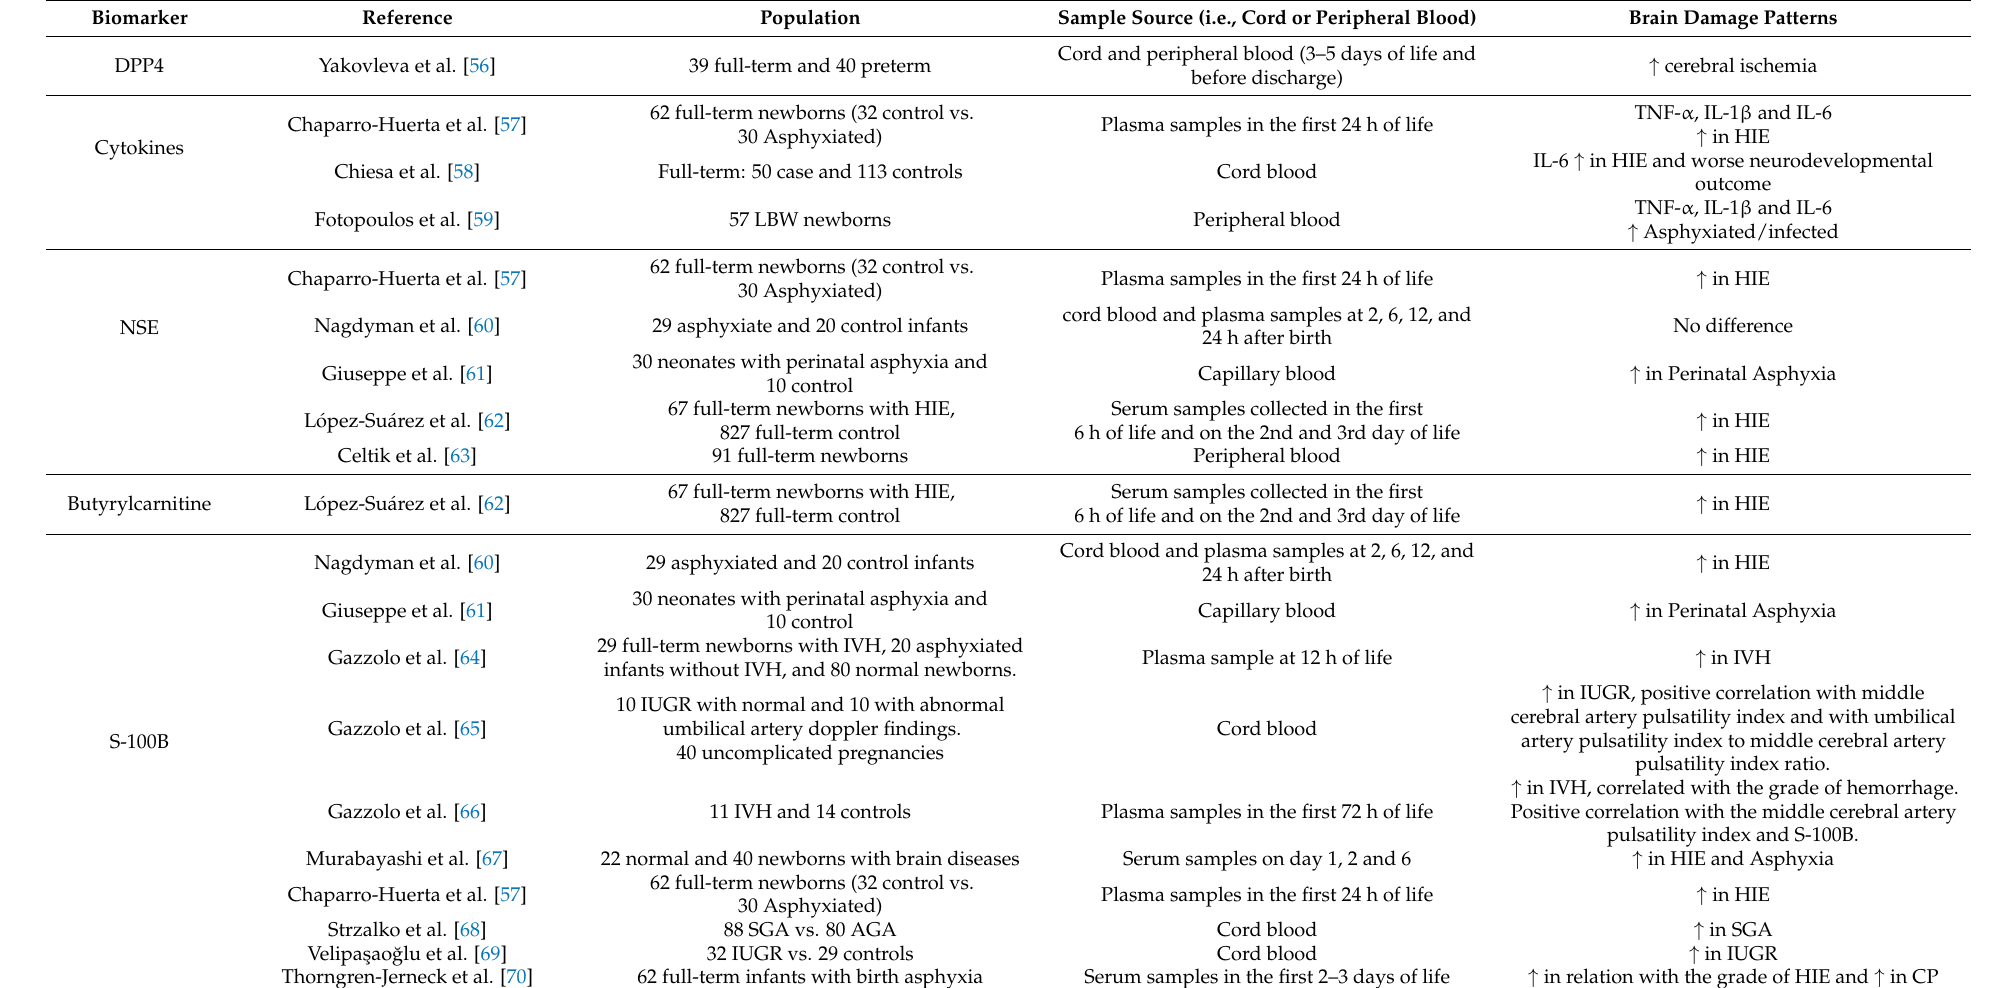
Table 1. Summary of the studies that evaluated the relation between serum biomarkers and brain damage in